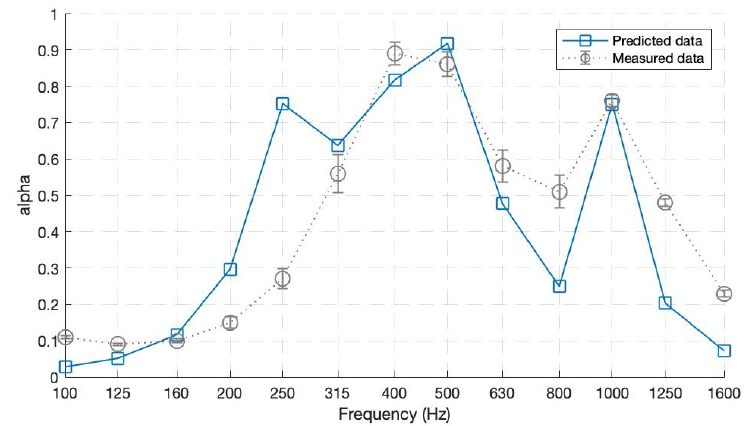
Figure 10. Absorption coefficients for Prototype 1—One layer with four parallel-arranged